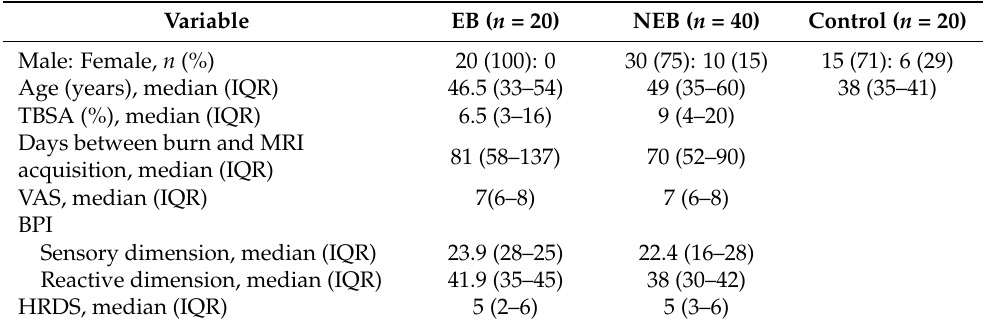
Table 1. Demographic data of